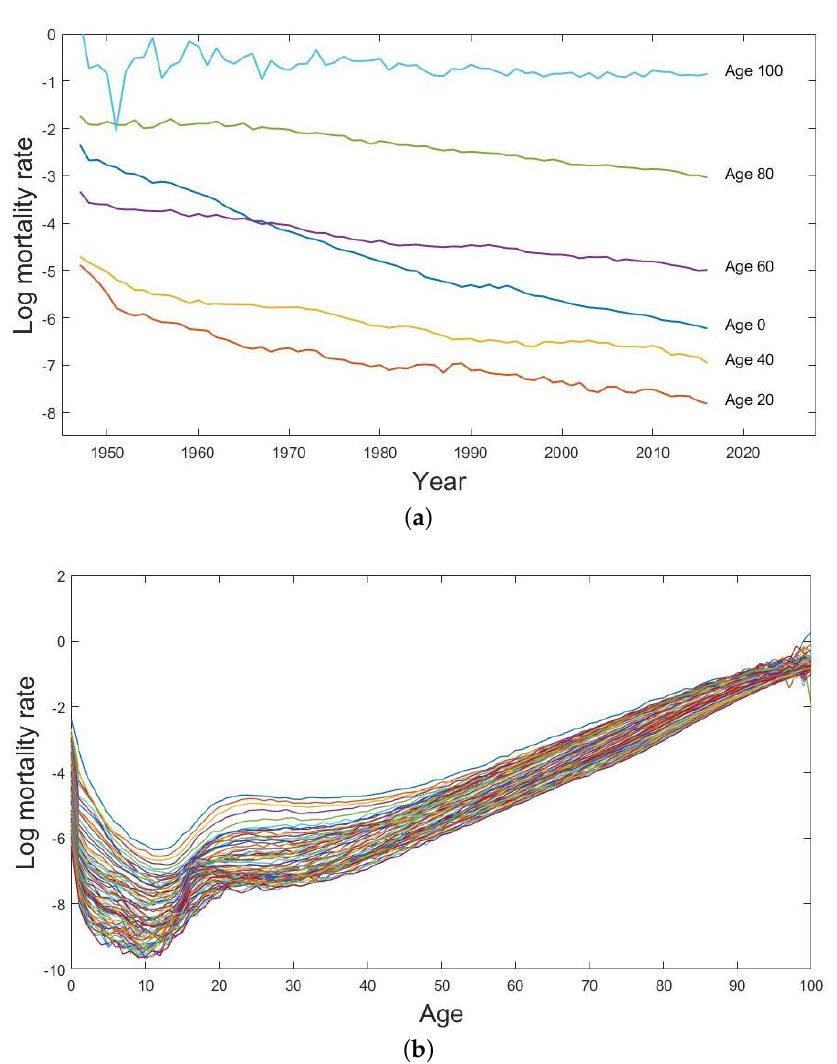
Figure 1. ( a ) Univariate time series of the log age-specific male mortality rates with 20-year age intervals and ( b ) the log male mortality curves from age 0 to age 100 from the year 1947 to the year 2016 in